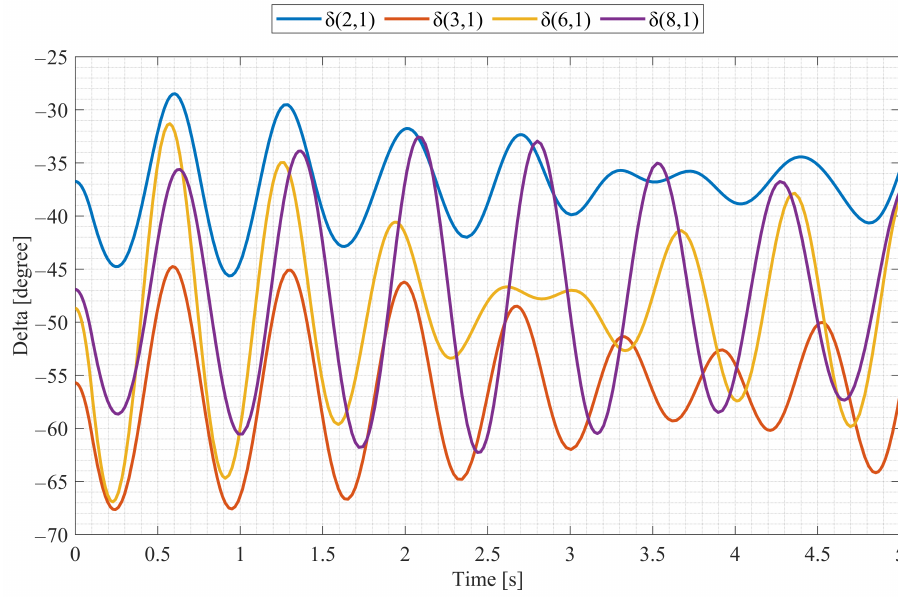
Figure 12. Generator angle oscillation, generator 1 is the reference in the IEEE 14-bus bar system.